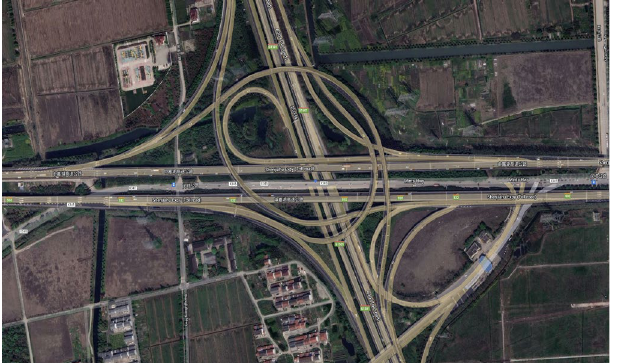
Figure 7. Test scenario.